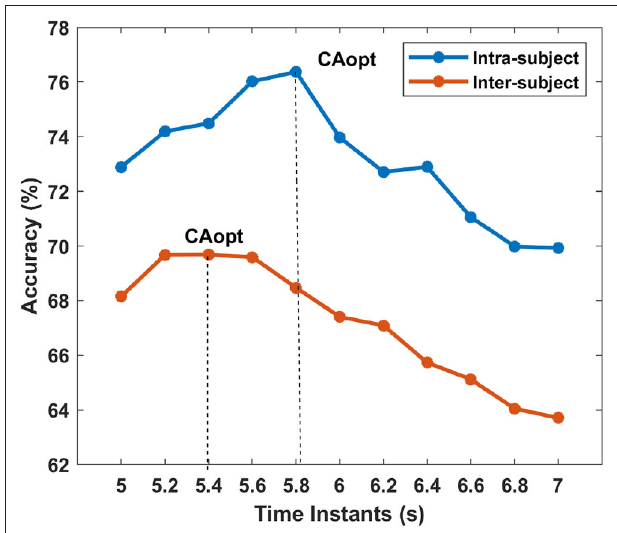
FIGURE 6 | The average accuracy across the subjects for each time instants are shown for intra- and inter-subject learning. The vertical lines show the time-point where is accuracy is maximum for intra- and inter-subject learning, i.e., the average CA opt